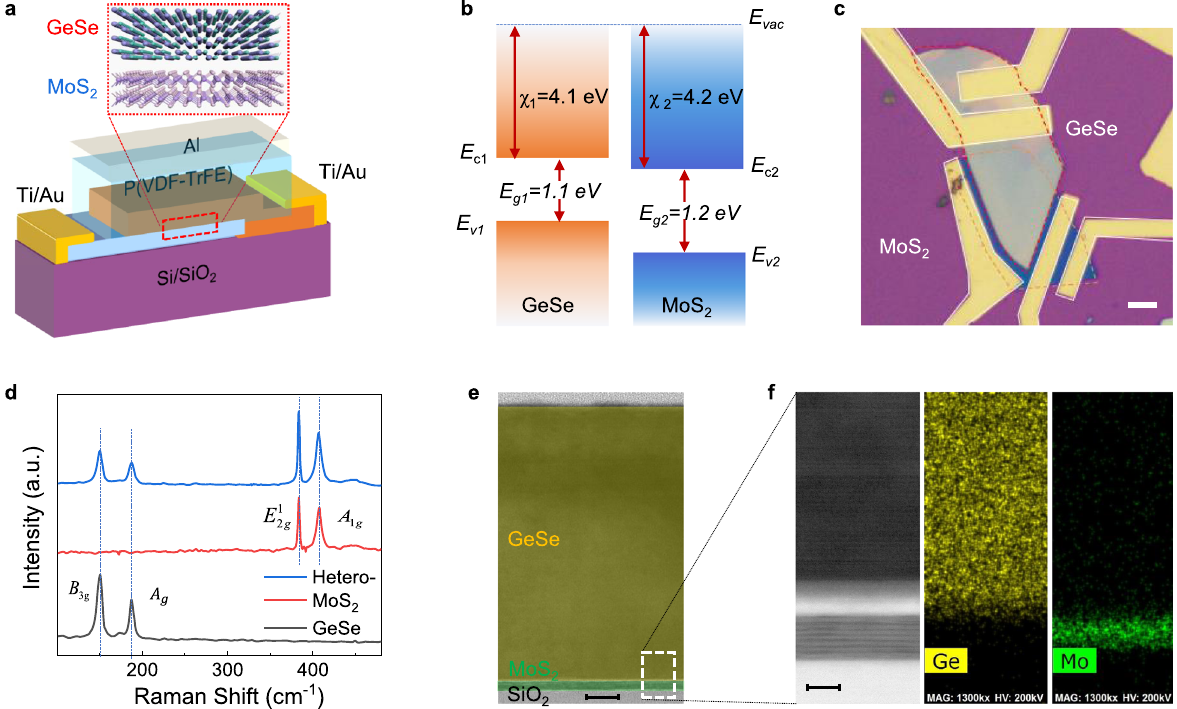
Fig. 1 Design and characterization of GeSe/MoS 2 heterojunction. a Schematic illustration of the GeSe/MoS 2 heterojunction with the P(VDF-TrFE) gate. b Energy bands of GeSe and MoS 2 before contact. χ 1 , χ 2 , E g1 , and E g1 are from related literatures. c Optical micrograph of the heterojunction; scale bar: 5 μ m. d Raman spectra of GeSe and MoS 2 and their overlap. e TEM image of the heterostructure; scale bar: 10 nm. f High-resolution cross-sectional image of the GeSe/MoS 2 interface and the corresponding chemical element distribution; scale bar: 5